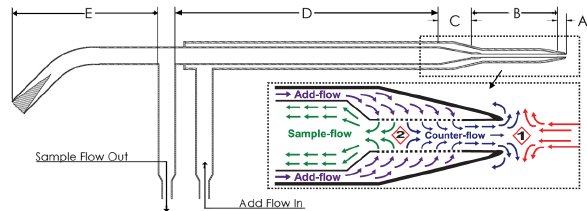
Fig. 1. Schematic depiction of the BMI CVI inlet and the flows in- nate to its operation (inset, not to scale). Sampled air enters the CVI through the inlet nozzle and passes through a region containing a porous tube where the heated counter-flow is introduced (A). The resulting sample flow enters an extension tube (B), before the ex- pansion region (C). (Note that the expansion angle of the diffuser between the extension tube behind the tip and the sample tube is 10.1 ◦ .) The particles then travel through additional plumbing (D) and enter the aircraft body for sample feed to instruments. Entities too large to bend into the aircraft are collected in a particle trap (E). Two stagnation planes (labelled 1 and 2) are generated between op- posing flow directions. The cut size is governed by the velocity of the ambient air flow and the distance between the two stagnation